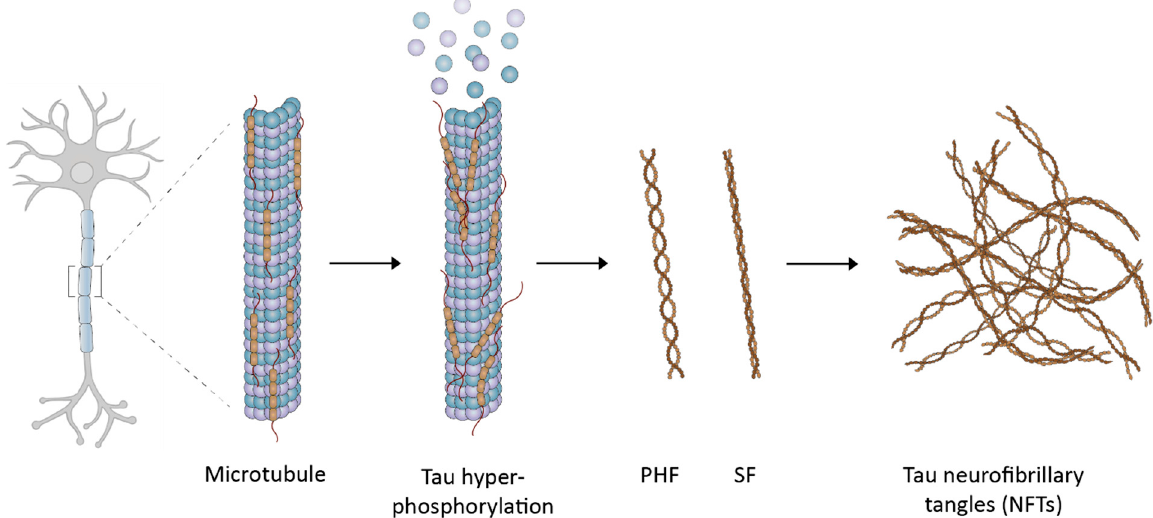
Figure 2. The development of tau neurofibrillary tangles (NFTs): tau proteins self-aggregate to form loosely intertwined paired helical filaments (PHFs) and the tightly wrapped straight filaments (SFs), which then leads to the formation of NFTs.